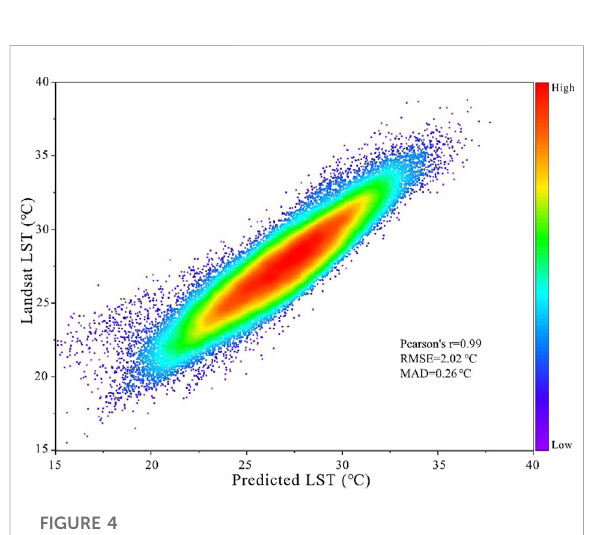
FIGURE 4 Scatter plot between the estimated and the observed land surface